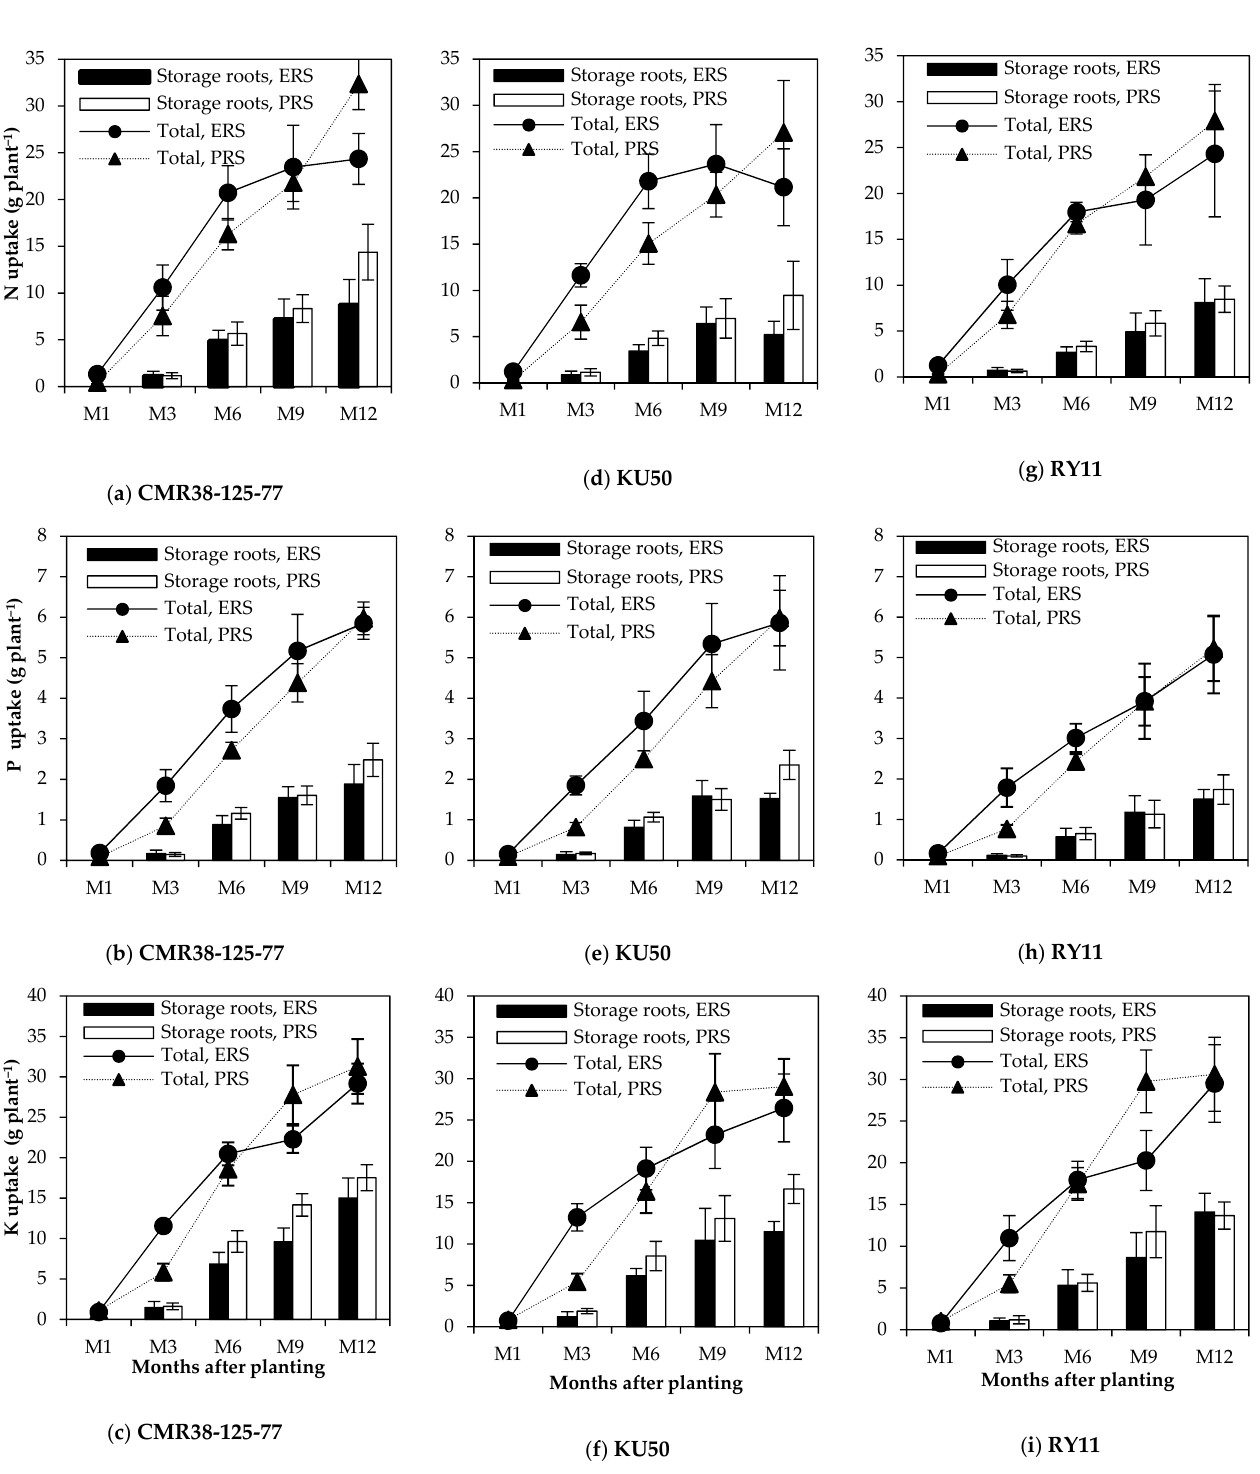
Figure 2. ( a – i ) Total nitrogen, phosphorus and potassium accumulation and their accumulation in storage roots (g plant − 1 ) of three cassava genotypes in the early rainy season (ERS) and post rainy season (PRS) with full irrigation. Each point represents the mean, and bars show standard deviation ( n = 4). N = nitrogen; P = phosphorus; K = potassium; KU50 = Kasetsart 50; RY11 = Rayong 11.